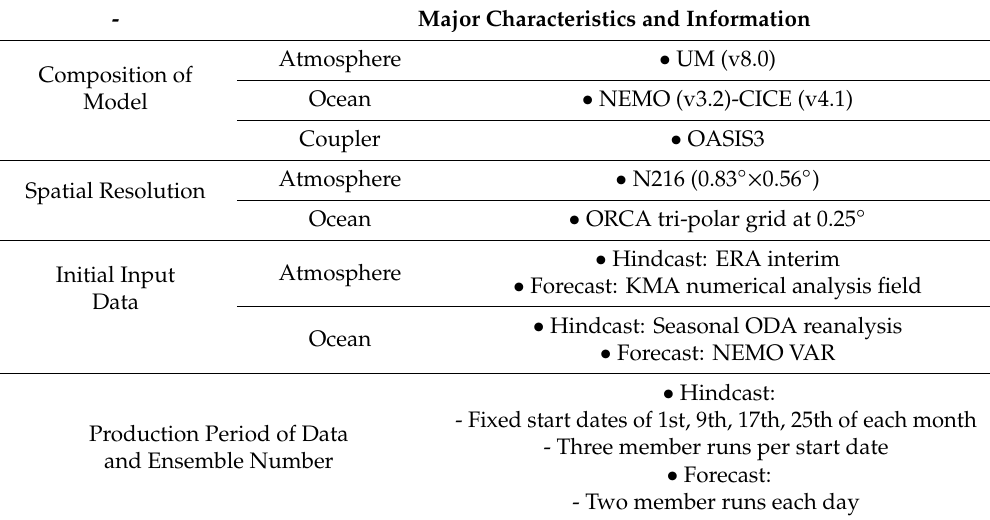
Table 1. Characteristics and information of Global Seasonal Forecast System version 5